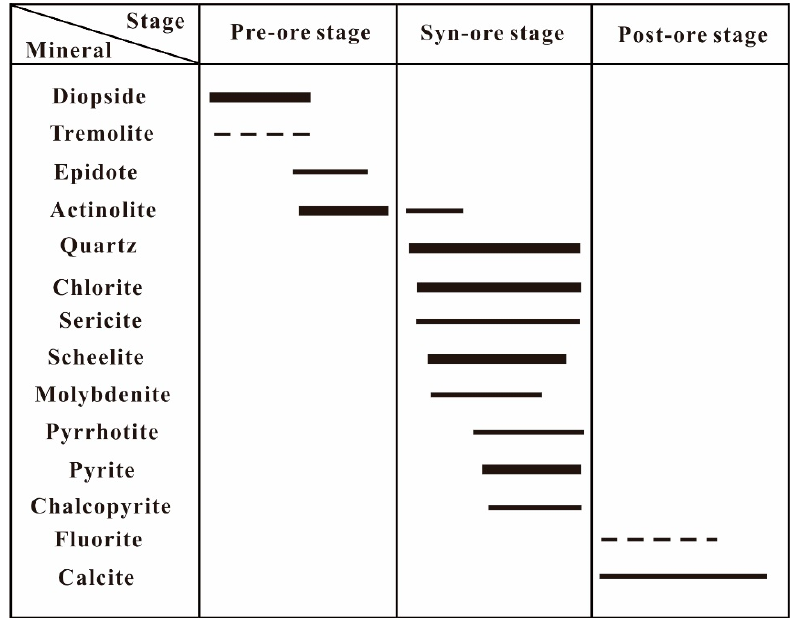
Figure 5. The paragenetic sequence of gangue and ore minerals in the Shangfang W deposit. Line thickness represents the relative amount of